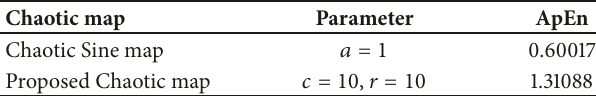
Table 2: Comparison of approximate entropy for two chaotic maps. Chaotic map